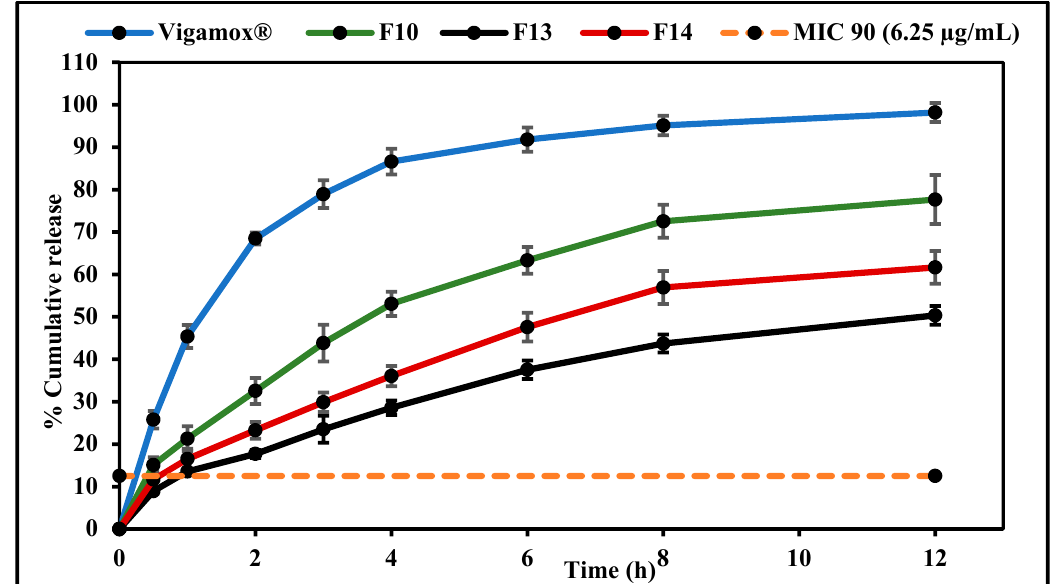
Figure 3. In vitro release profiles of moxifloxacin from Vigamox ® , F10, F13, and F14 formulations determined by a Thermo Scientific™ Slide-A-Lyzer™ MINI dialysis device (10 K MWCO) (mean ± SD, n = 3). Table 7. Mathematical model fitting of release kinetics of moxifloxacin from F10, F13, and F14 for- mulations (mean ± SD, n = 3).